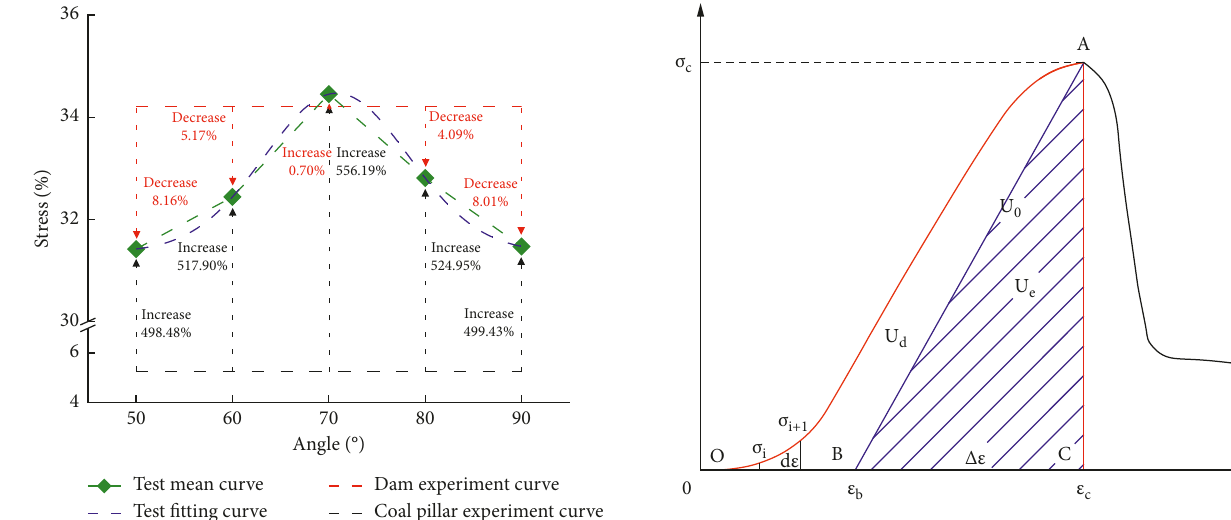
Figure 12: Schematic diagram of energy evolution on the sample. Energy input U o can be represented by the OAC area in Figure 12. A straight line parallel to the stress–strain plot along the peak point, and a straight line perpendicular to the axis at the peak point are drawn. The area of the triangle formed is the accumulated elastic energy U e (ABC area in Figure 12). The area occupied by OAB shown in Figure 12 is the dissipation energy U d .